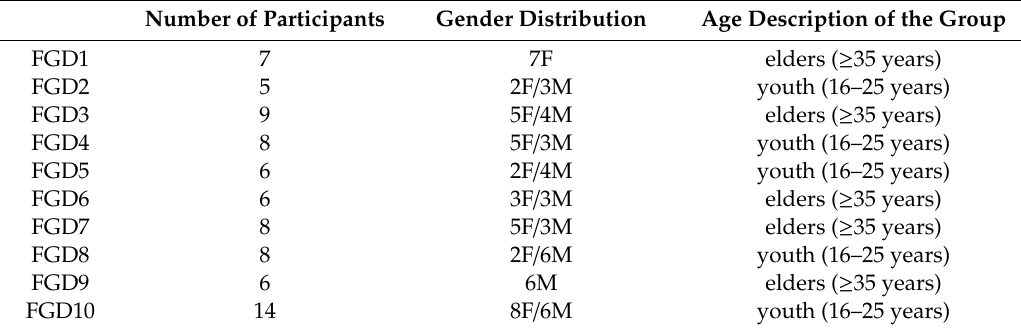
Table 3. Characteristics of the participants in Focus Group Discussions